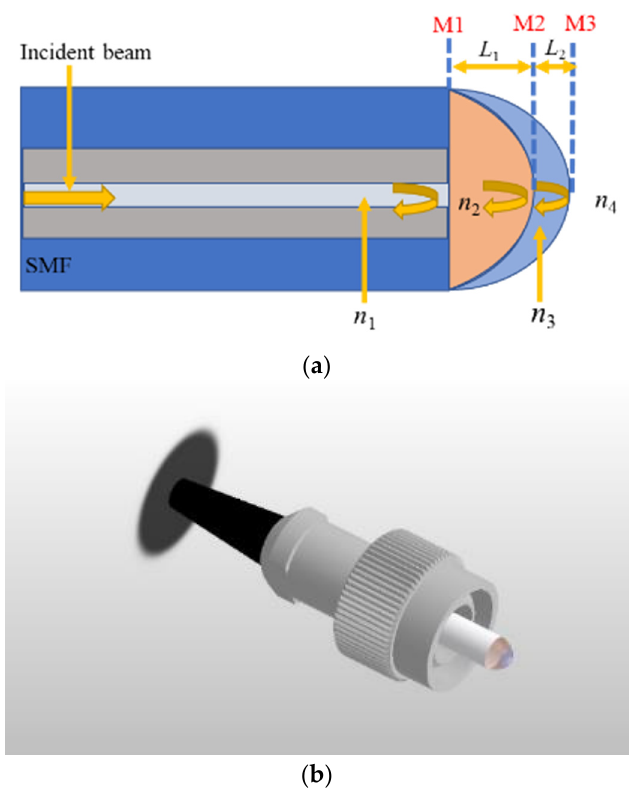
Figure 1. ( a ) Schematic diagram and ( b ) 3D illustration of proposed sensor. Firstly, a drop of the low RI glue was dropped on a slide. Then, the end face of the fiber patch cord was shallowly dipped into it vertically. A hemispherical film would be formed on the end face after the fiber was moved up, due to surface tension of the glue. During the whole process, the reflection spectrum was monitored in real-time by an optical spectrum analyzer (ADVANTEST Q8384). If the thickness of the film needs to be slightly adjusted, the connector can be turned bottom-up. Under the combined action of the viscosity of the glue and gravity, the thickness of the film will change slowly. When the desired spectrum was observed on the OSA, the UV light source was tuned on to cure the glue quickly. The reflection spectrum after the curing of the first layer is shown in Figure 2a. It can be seen that the peak-valley difference is about 20